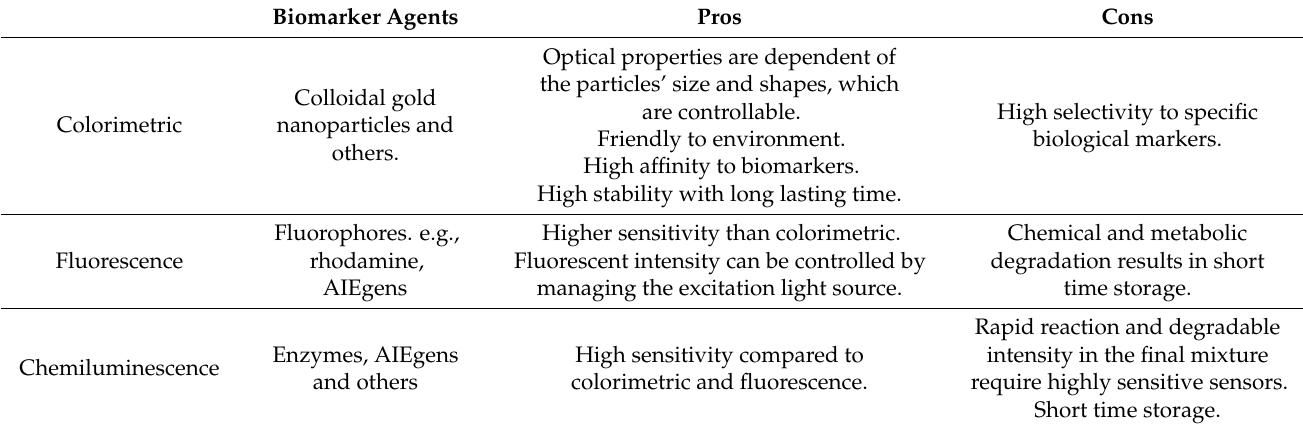
Table 1. Summary of the microfluidic paper-based strip applied in three optical detecting methods: [44].